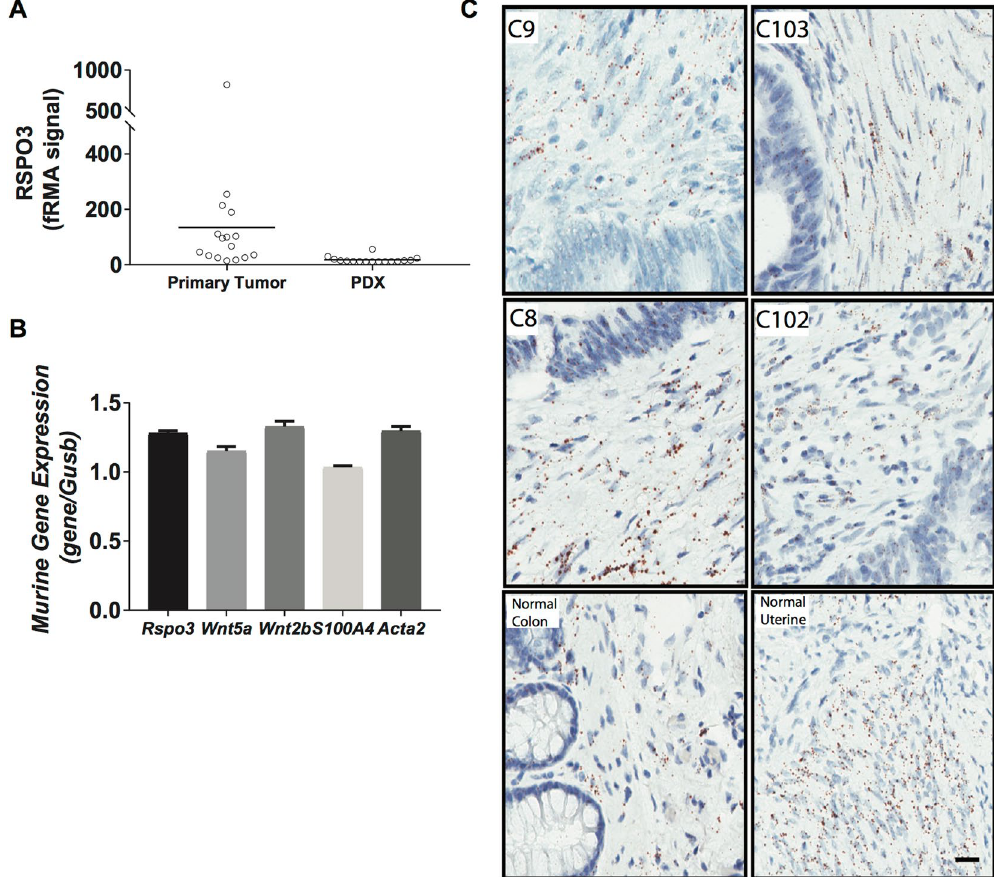
Figure 2. Colorectal cancers contain high levels of RSPO3 that is associated with the tumor microenvironment. ( A ) Microarray analysis of RSPO3 expression in primary CRC cancer and PDX tumors. Primary tumors (Tumor) express human RSPO3 while the expression of human RSPO3 is lost in the PDX. ( B ) qPCR of PDX models detects murine Rspo3 , Wnt , and Tumor Associated Fibroblast markers, S100a4 and Acta2 . OMP-C40 tumor model whole tumor lysate, qPCR performed on Fluidigm Biomark. ( C ) Detection of RSPO3 by ISH using RNAscope. Primary patient colon tumor tissues used to create PDX tumors OMP-C9, OMP-C103, OMP- C88, OMP-C102, and normal human colon and uterine tissues were tested with the RNAscope ® 2.5 VS Reagent kit, using probes for RSPO3. RSPO3-ISH is shown as brown dots and nuclei as blue. Scale bar = 20 μ